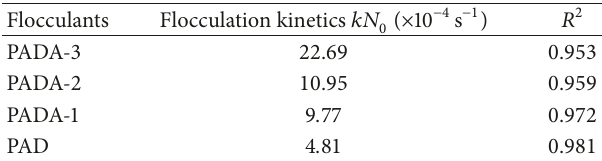
Table 2: The flocculation kinetics (𝑘𝑁 0 ) for the four flocculants (PADA-3, PADA-2, PADA-1, and